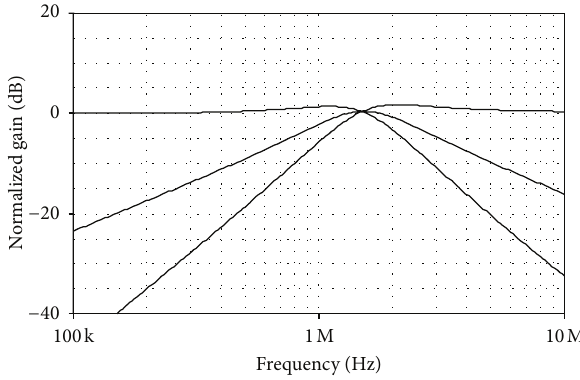
Figure 14: Simulated 𝐿𝑃,𝐵𝑃 , and 𝐻𝑃 current responses for the filter in Figure 13.